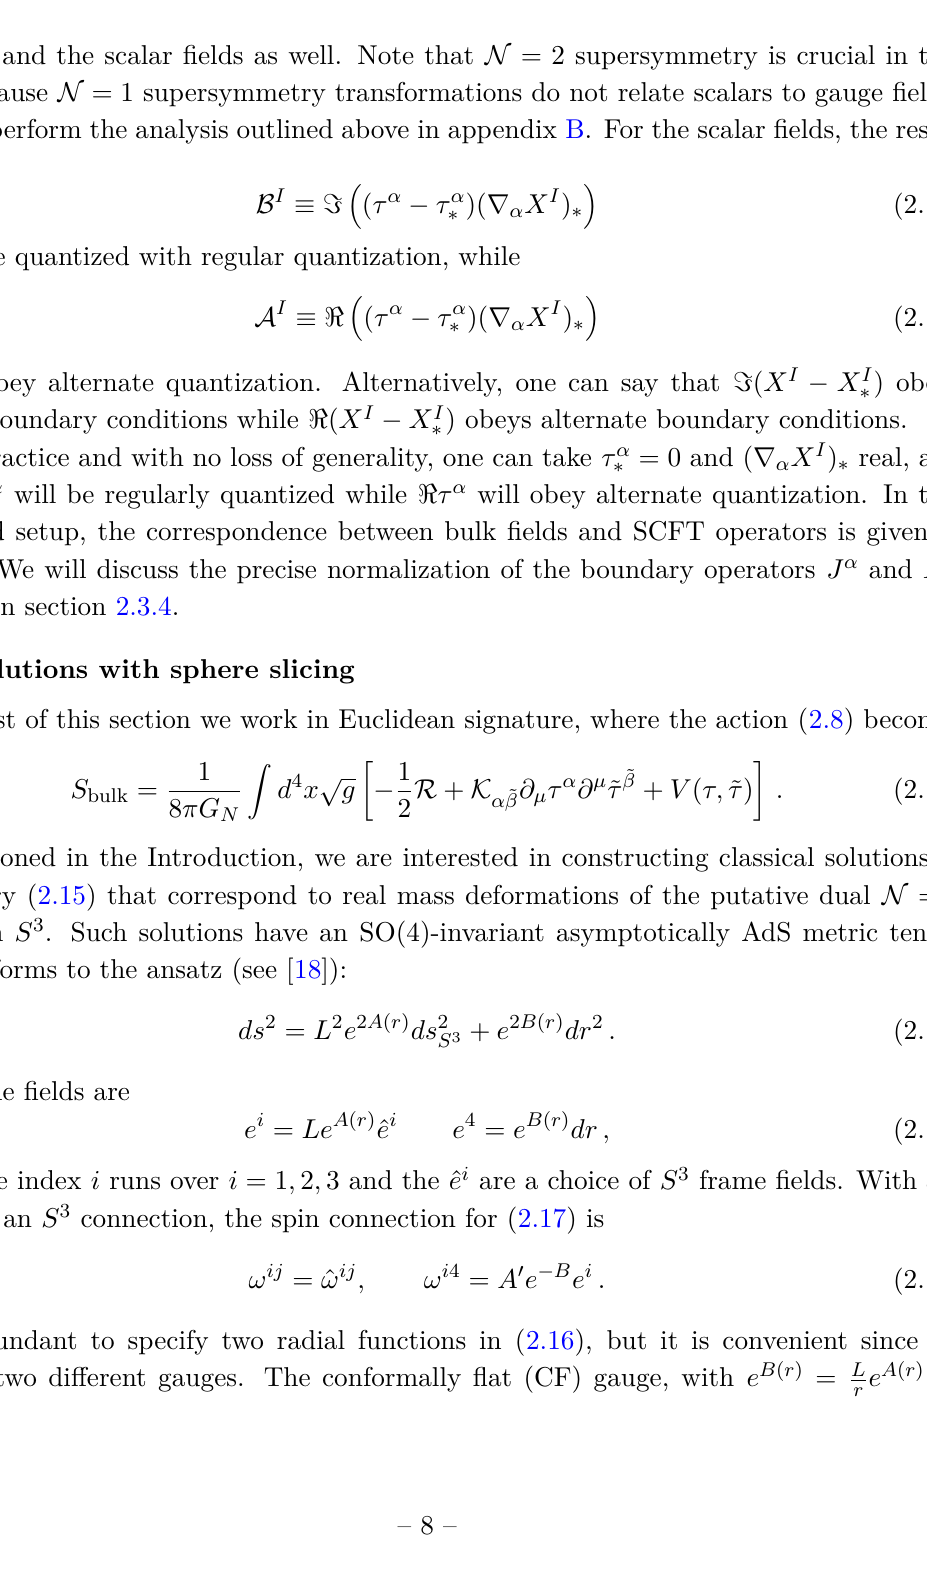
Table 1. Correspondence between bulk fields and boundary operators in the N = 2